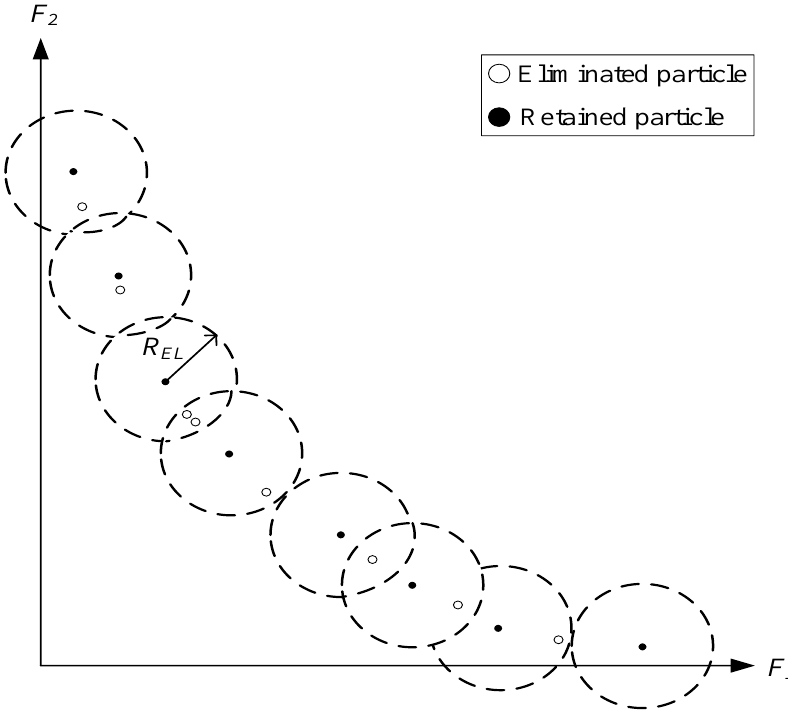
Figure 2. Dynamic elimination technique adopted for hybrid GA-PSO